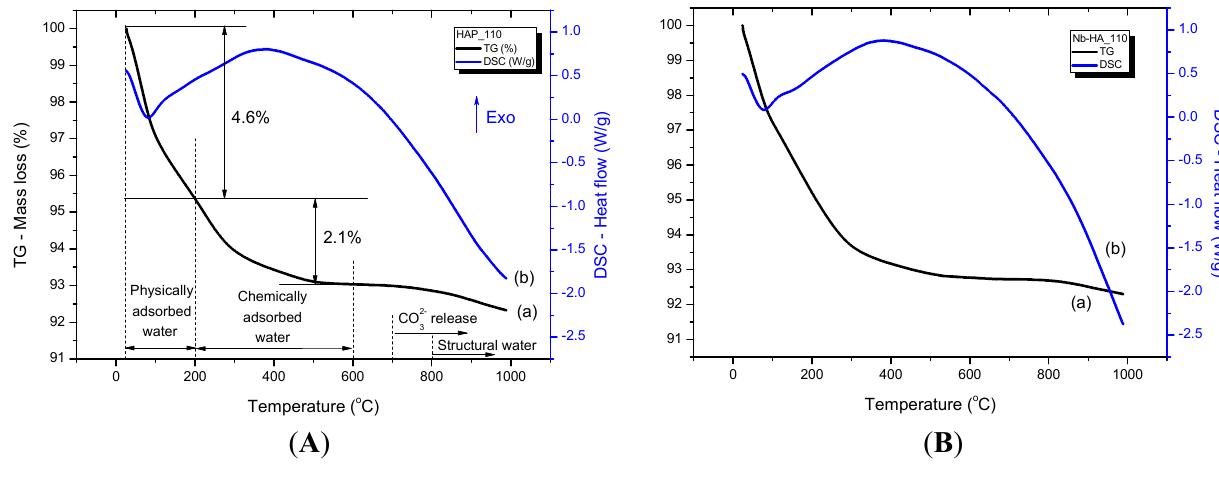
Figure 5. TG (a) and DSC (b) curves of HA_110 ( A ) and Nb-HA_110 ( B ).